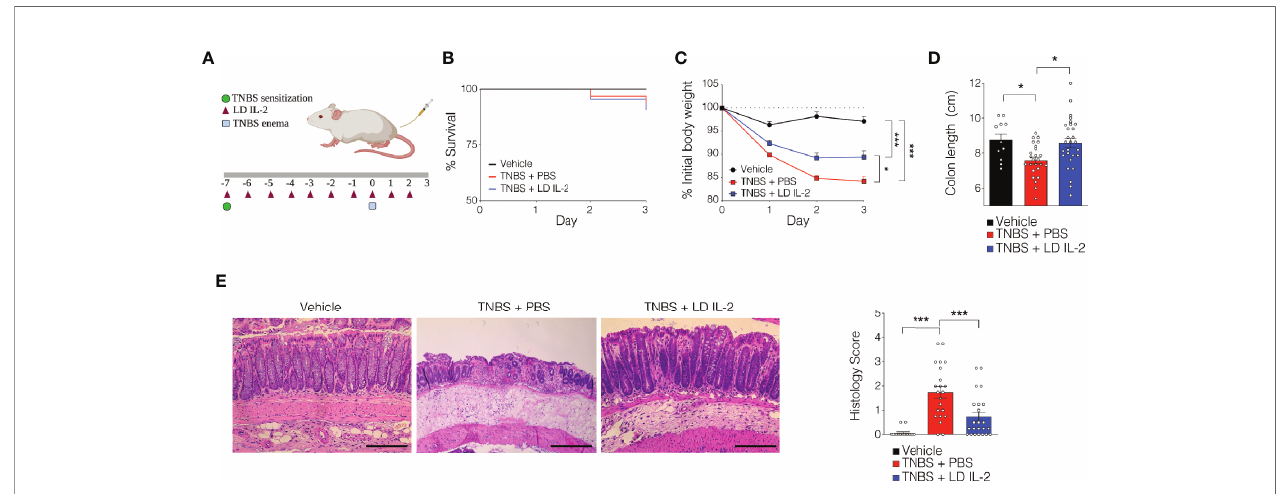
FIGURE 1 | Low-dose (LD) interleukin-2 (IL-2)-mediated protection against trinitrobenzensulfonic acid (TNBS)-induced colitis is independent of T reg cell human leukocyte antigen (HLA) restriction. (A) Schematic of LD IL-2/TNBS protocol. (B) Percent survival of NOD. Prkdc scid Il2rg -/- (NSG) human immune system (HIS) mice post-TNBS rectal administration (vehicle n = 11; PBS n = 28; LD IL-2 n = 30). (C) Percent initial body weight following induction of TNBS-induced colitis in NSG HIS mice treated with or without LD IL-2 (vehicle n = 11; PBS n = 28; LD IL-2 n = 30). (D) Colon length 3 days following vehicle or TNBS enema. Each dot represents an individual animal (vehicle